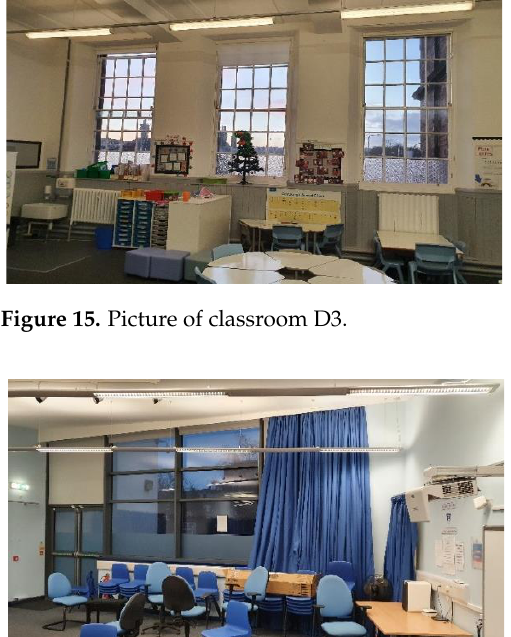
Figure 16. Picture of classroom D5.